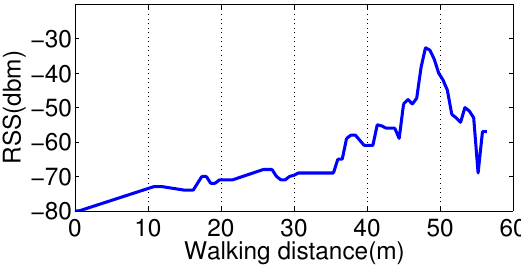
Figure 3. RSS variations when passing by an AP.